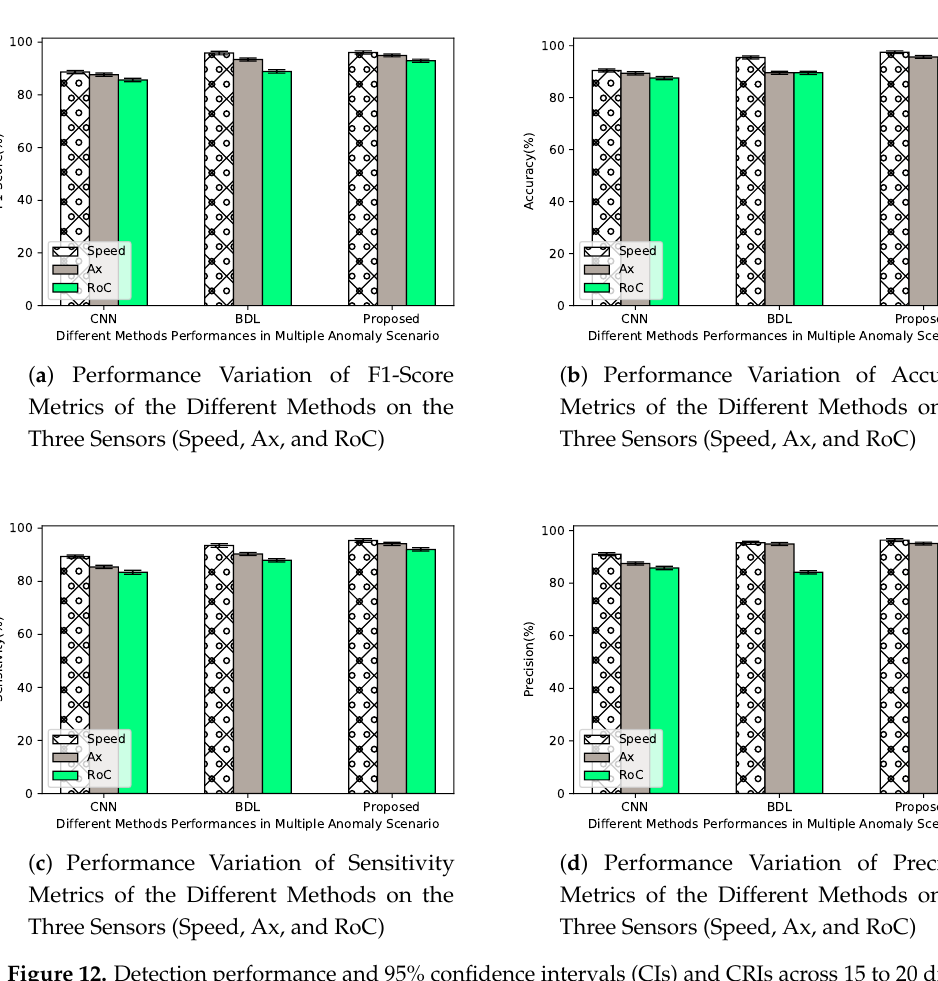
Figure 12. Detection performance and 95% confidence intervals (CIs) and CRIs across 15 to 20 different executions for all three methods, at anomaly rate α = 50% an in the presence of all the types of